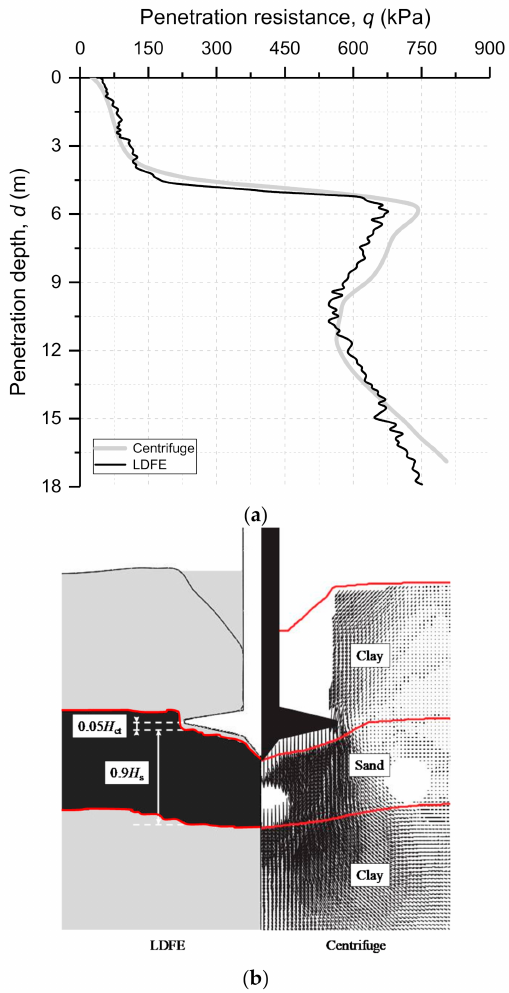
Figure 5. A comparison of experimental and numerical results for Test T3SP of Ullah et al. [19]. ( a ) Penetration resistance profiles; ( b ) soil plug